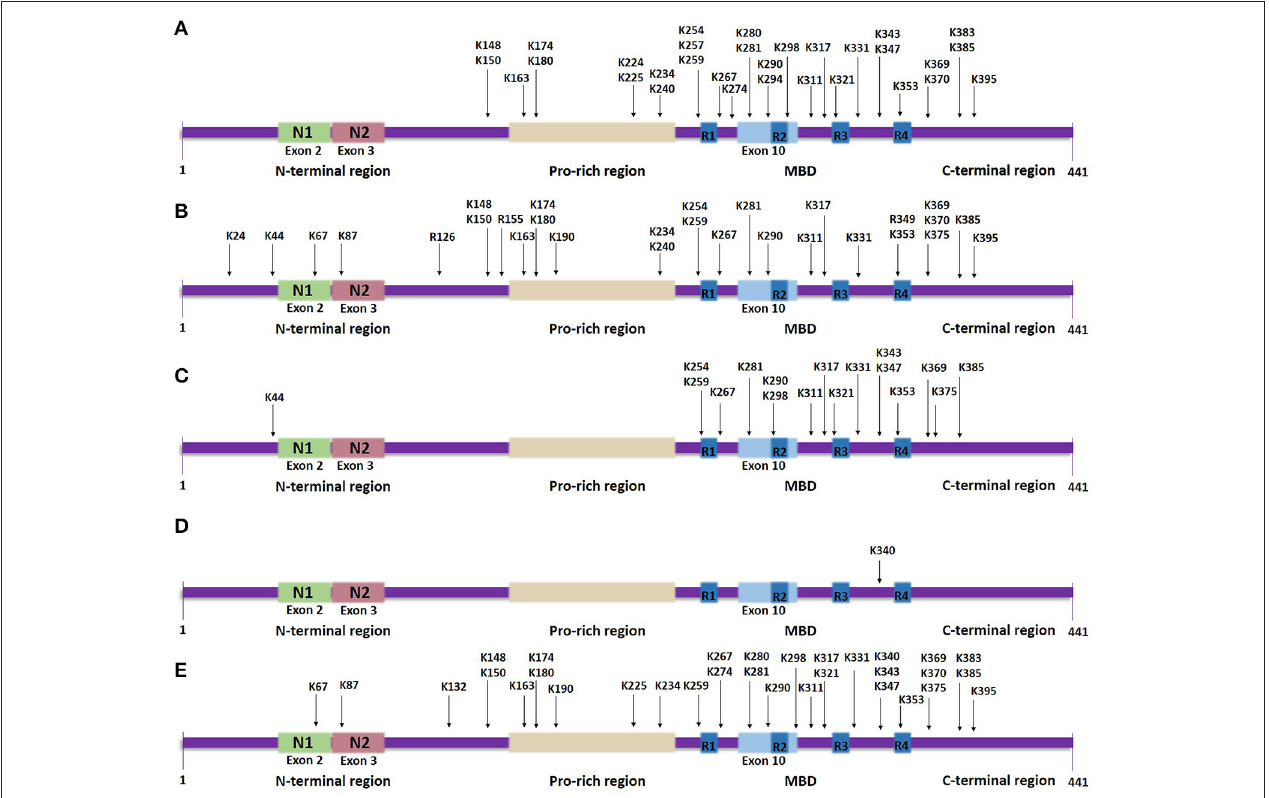
FIGURE 3 | Tau lysine-specific sites that are modified post-translationally based on the longest human tau isoform. The modified sites include the total number of sites that have been identified both in vivo and in vitro, in normal tau as well as in pathological states of tau. (A) Tau acetylation sites. (B) Tau methylation sites. (C) Tau ubiquitylation sites. (D) Tau SUMOylation site. (E) Tau glycation